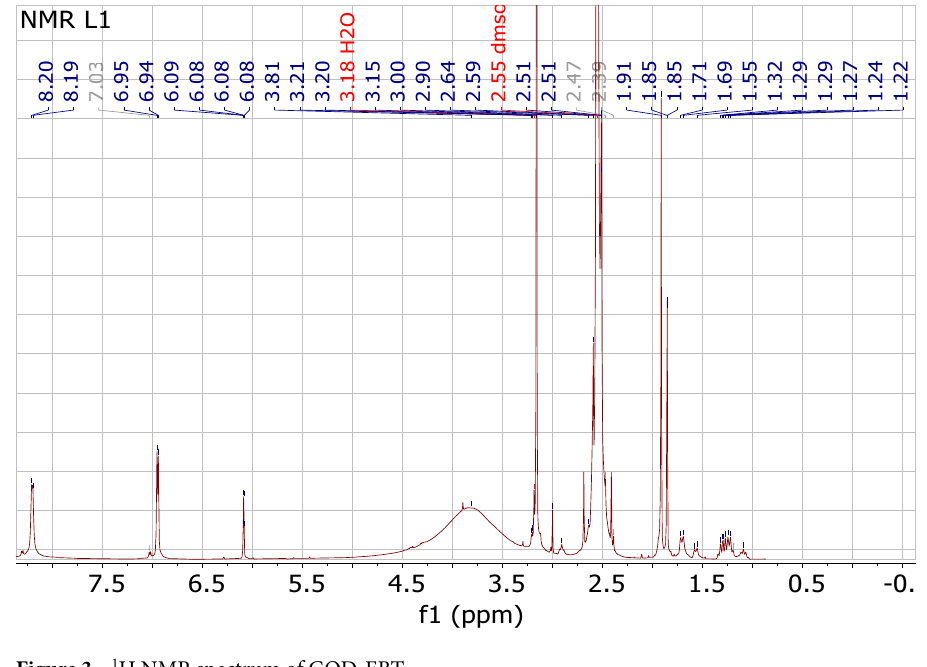
Figure 3. 1 H NMR spectrum of